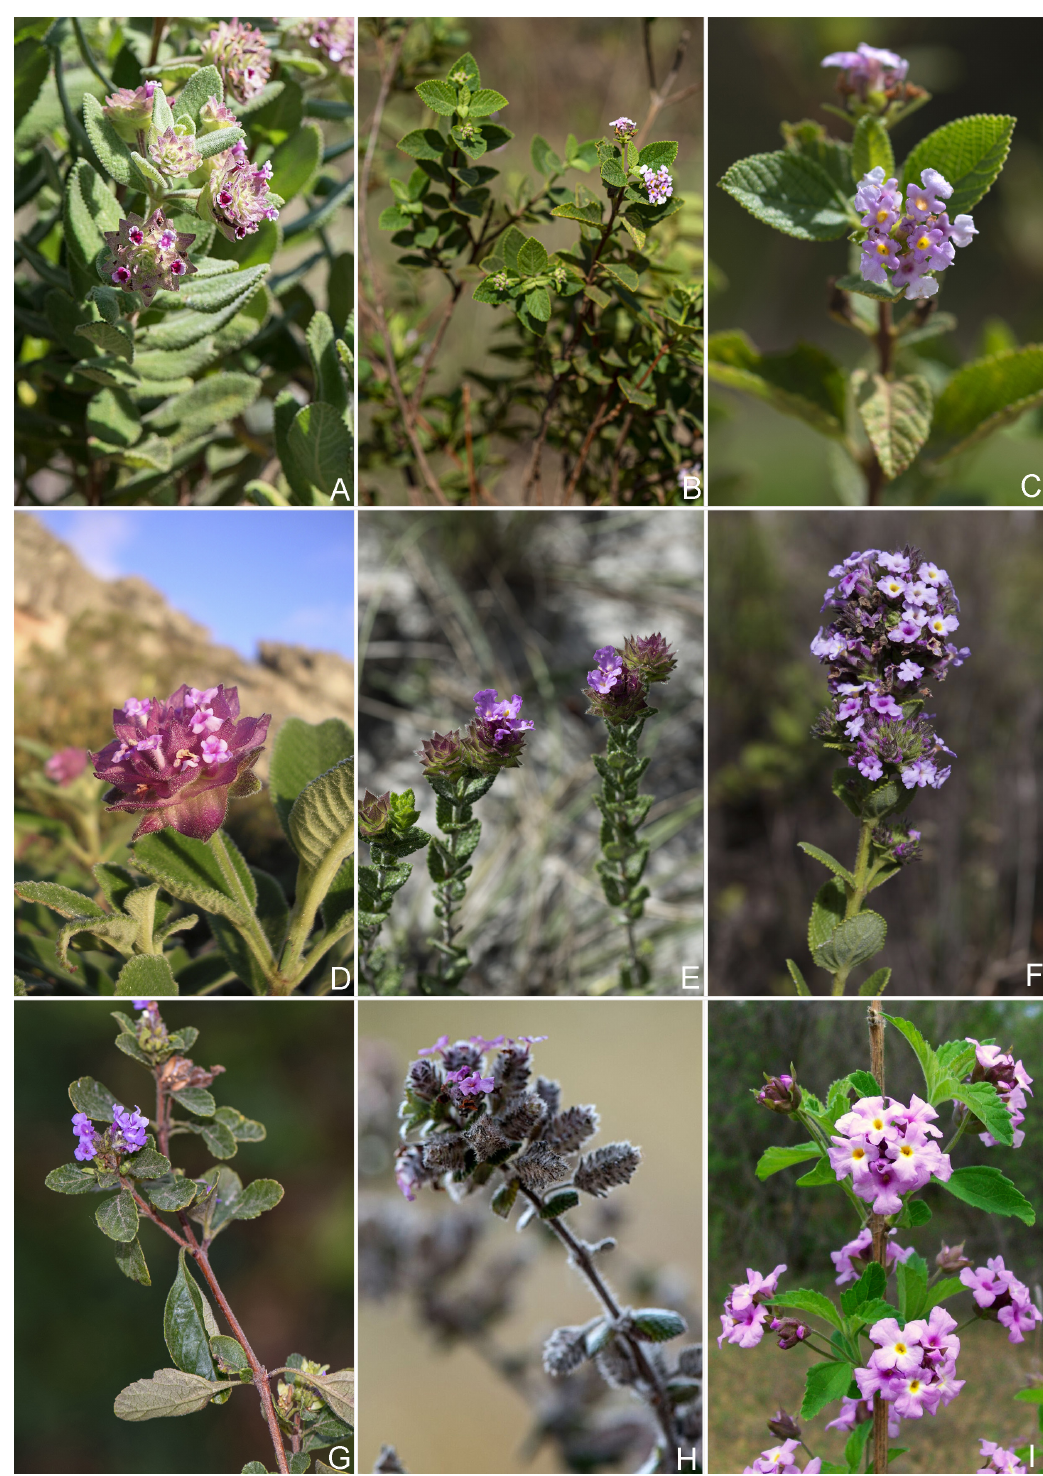
Fig. 4. A . Lippia pseudothea (A.St.-Hil.) Schauer . B–C . L. raoniana P.H.Cardoso & Salimena sp. nov. D . L. rhodocnemis Mart. & Schauer. E . L. rosella Moldenke. F . L. rotundifolia Cham. G . L. rubella (Moldenke) T.R.S.Silva & Salimena. H . L. stachyoides Cham. I . L. subracemosa Mansf . Photos: A–C, E, G–H by Pedro Henrique Nobre; D by Luiz Menini Neto; F by Maurício Mercadante; I by Lucas